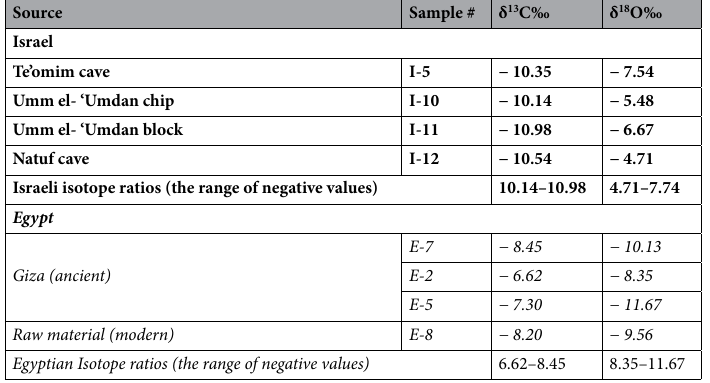
Table 2. Carbon (δ 13 C) and oxygen (δ 18 O) stable isotopic ratios. Israeli samples in bold, Egyptian samples in italics.